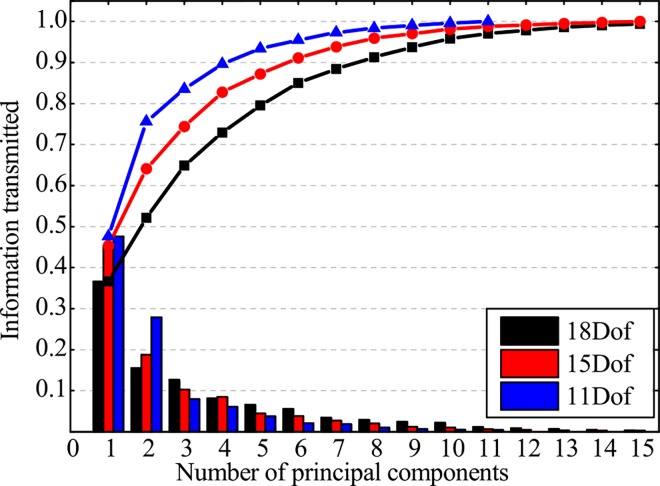
Information transmitted by each PC of postures contained different number of DOFs.The postures of different number of DOFs contained hand and wrist posture (18DoF), hand posture (15DoF), hand without thumb posture (11DoF) to all ten subjects.